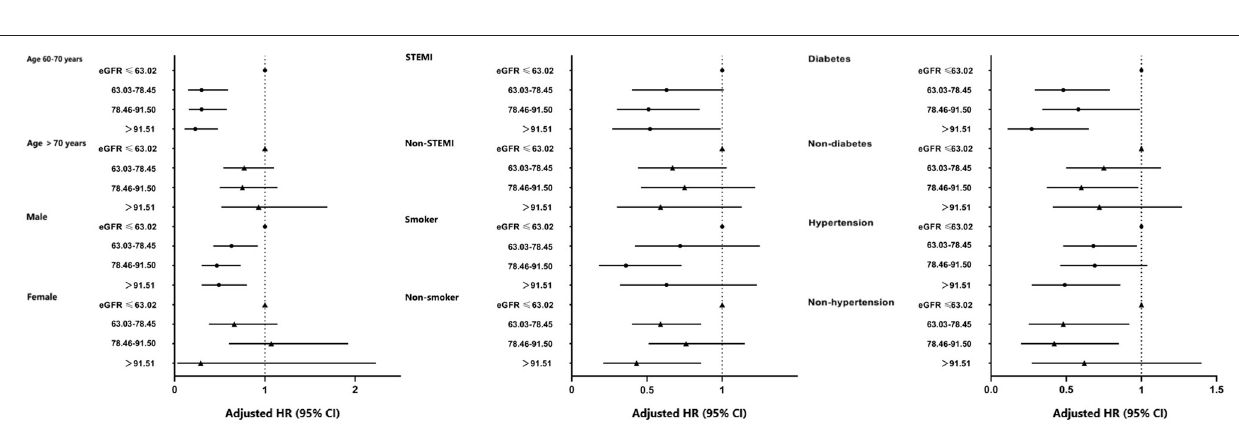
FIGURE 5 | Forest-plot of all-cause death according to different subgroups. Adjusted model included sex, age, BMI, smoke, patterns of acute myocardial infarction, drink, stroke, SBP, glycated hemoglobin, peak of CK-MB, peripheral vascular disease, and TG. BMI, body mass index; eGFR, estimated glomerular filtration rate; STEMI, ST-elevation myocardial infarction; SBP, systolic blood pressure; TG, triglycerides; HR, hazard ratio; CI, confidence interval; Ref., reference (eGFR ≤ 63.02 ml/min/1.73 m 2